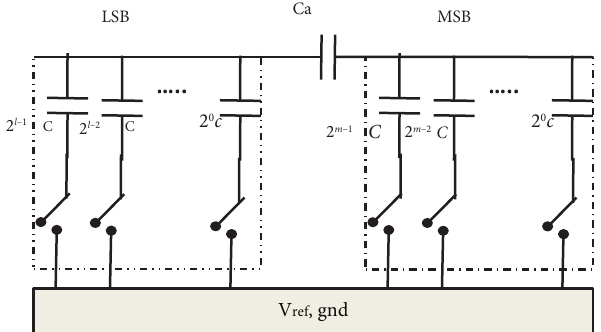
Figure 10: Te two-stage subarray capacitor technique.